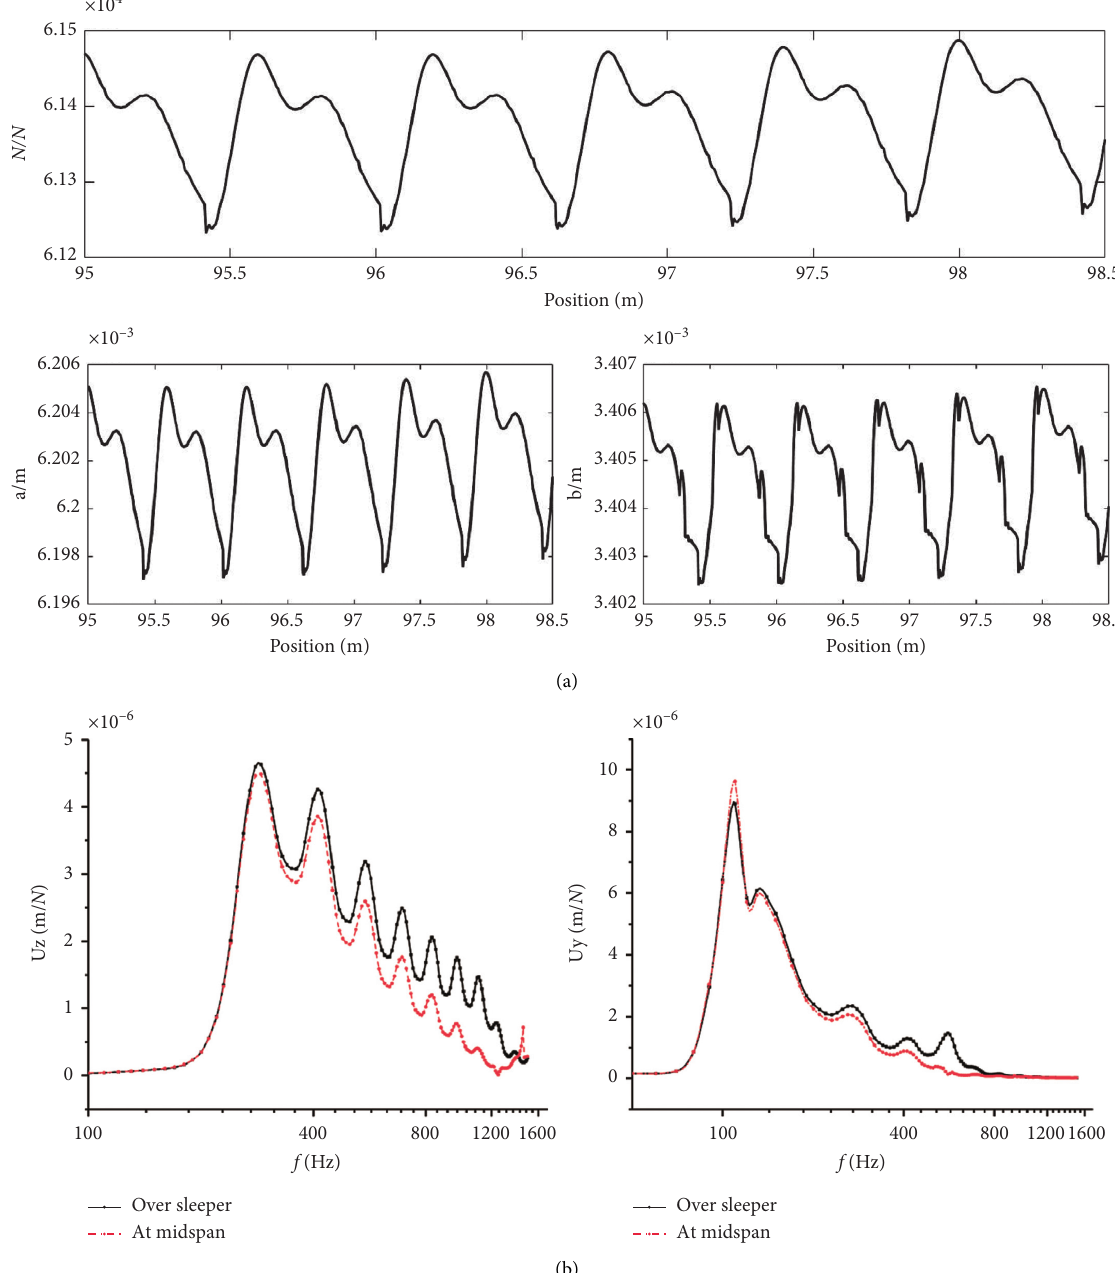
Figure 2: Fluctuation of related variables in the corrugation growth model: (a) influence of x on model parameter; (b) influence of x on rail